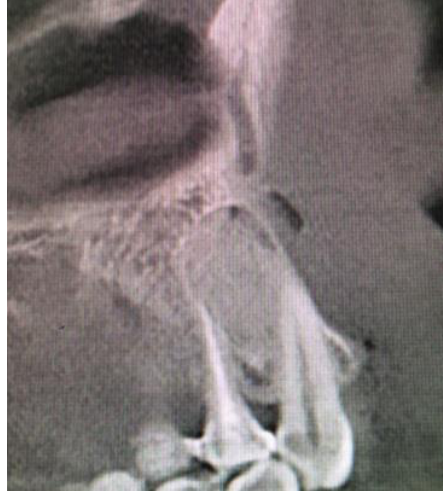
Figure 6. CBCT sagittal view after surgery.